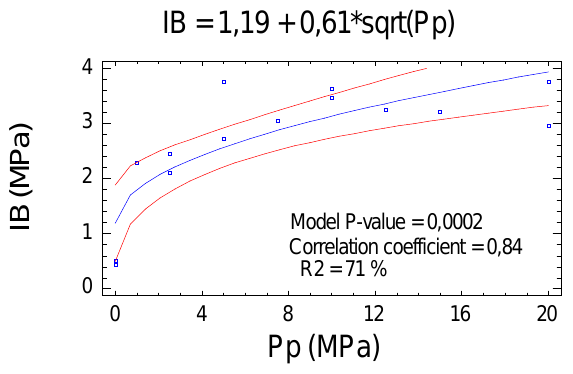
Figure 5. Influence of Pp on the internal bond (IB).